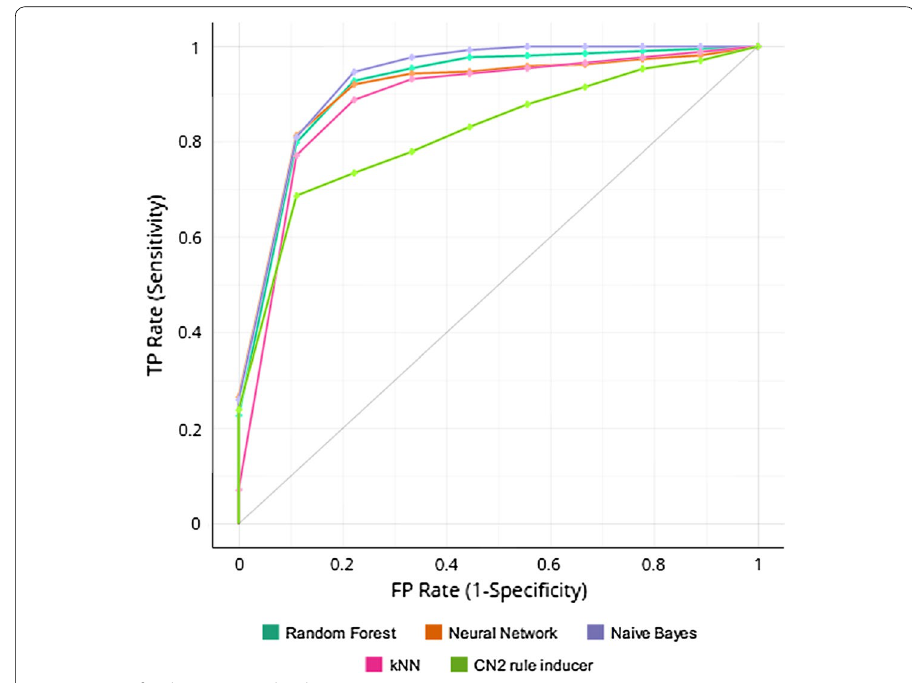
Fig. 14 ROC for the HDT IP upload TSC